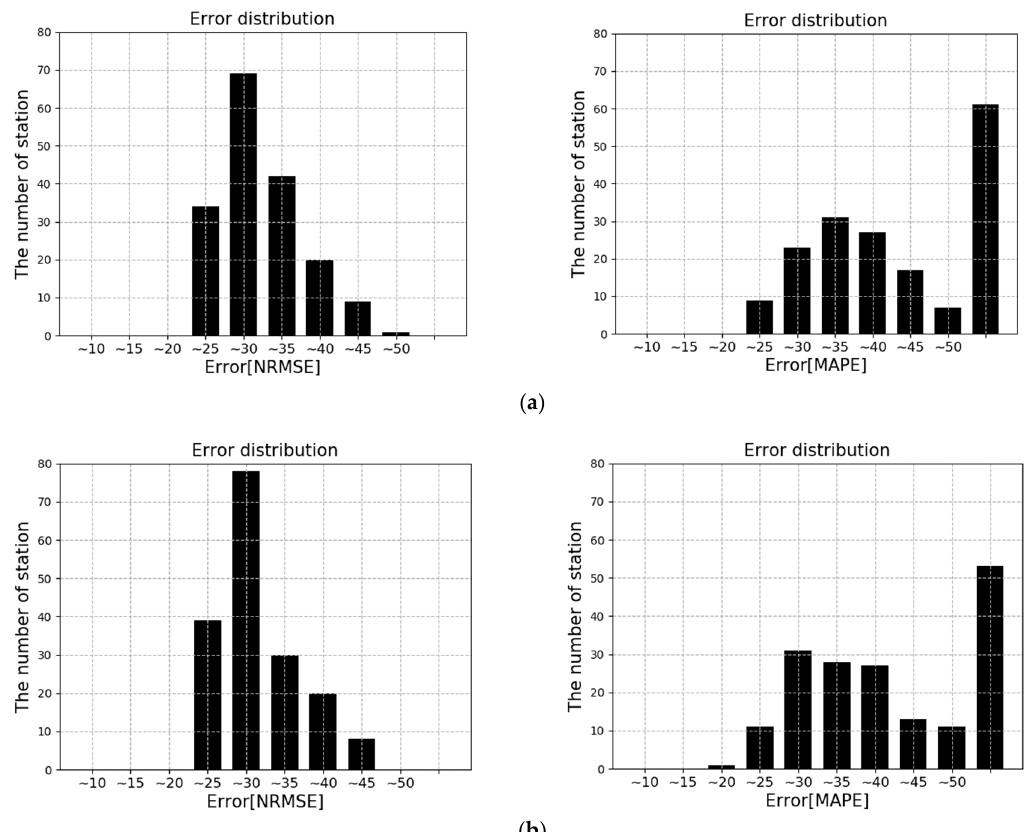
Figure 12. Graphs of energy consumption estimation error distribution ( a ) without recent data selection step and ( b ) with recent data selection step.